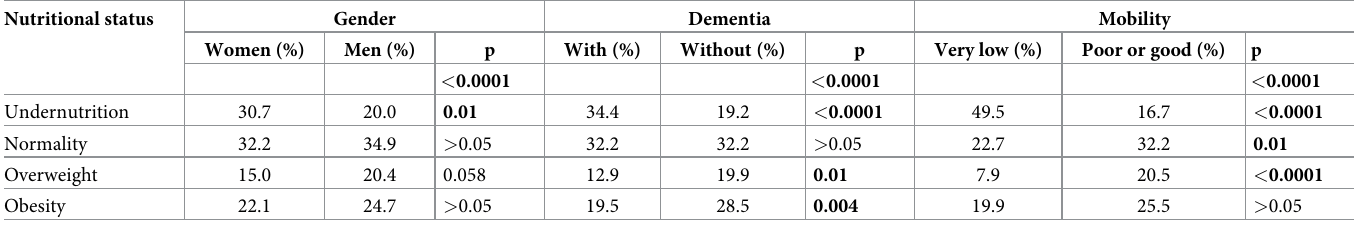
Table 2. Nutritional Status of residents based on gender, dementia, and mobility. Nutritional